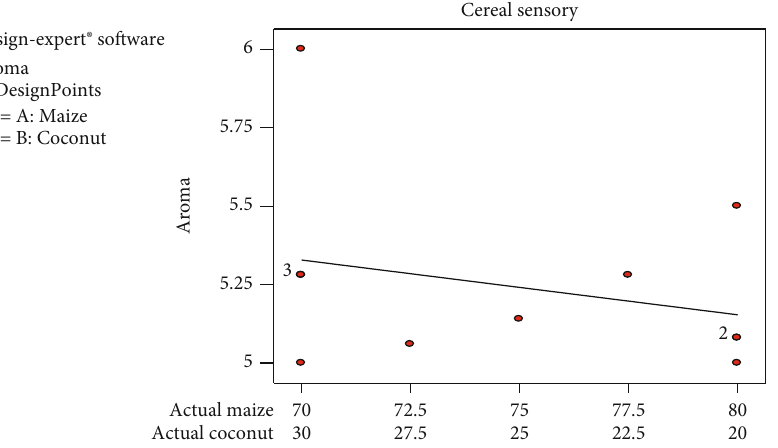
Figure 3: Mean graph for aroma sensory responses on the samples.